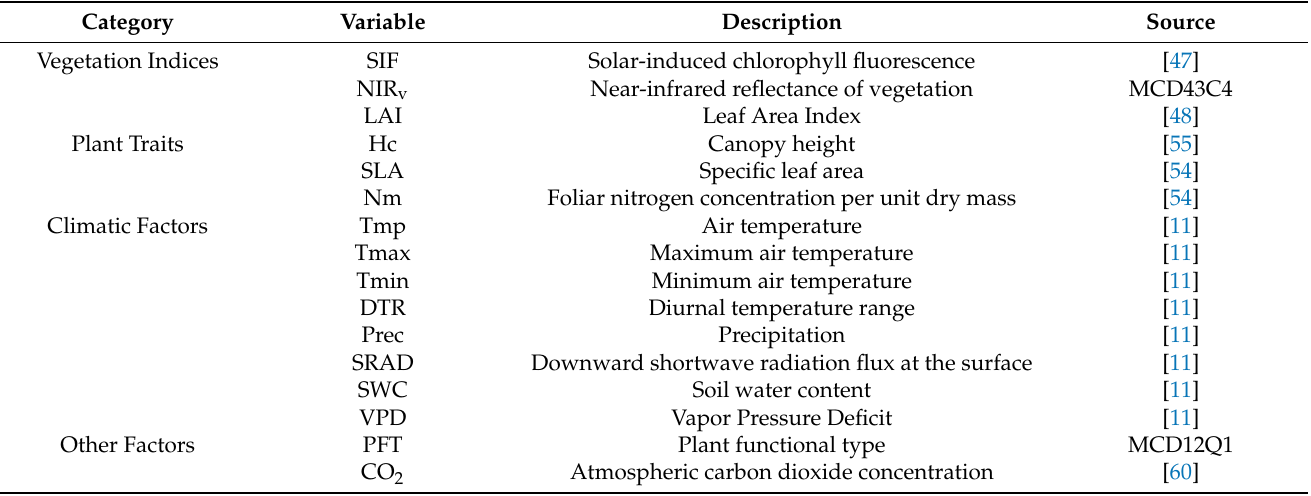
Table 1. Details of the datasets used in the data-driven